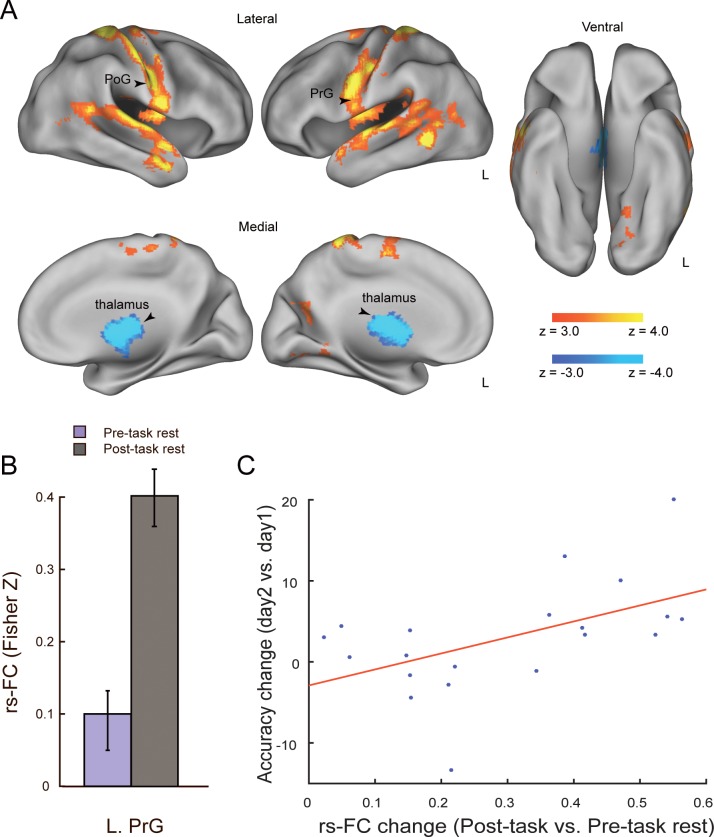
Training-induced rs-FC changes and brain-behavior correlation.(A) The statistical map indicates brain regions showing training-induced rs-FC changes with the MT+ seed (hot: Post-task > Pre-task rest, cold: Pre-task > Post-task rest). The arrow head indicates the left PrG. All maps are thresholded at P < 0.05, cluster-level FWE corrected across the whole brain. (B) Pre-task and post-task rs-FC between the MT+ and left PrG. The y axis indicates the correlations (Fisher Z transformed) between the time series extracted from the MT+ and left PrG, averaged across participants. The error bars indicate s.e.m. The bar graph is provided for visualisation purposes, and no statistical test was applied to this data. (C) Scatter plot showing individual differences in behavioural improvement (accuracy gain on day 2 relative to day 1) as a function of training-induced rs-FC change between the MT+ and left PrG. PoG: postcentral gyrus; PrG: precentral gyrus.